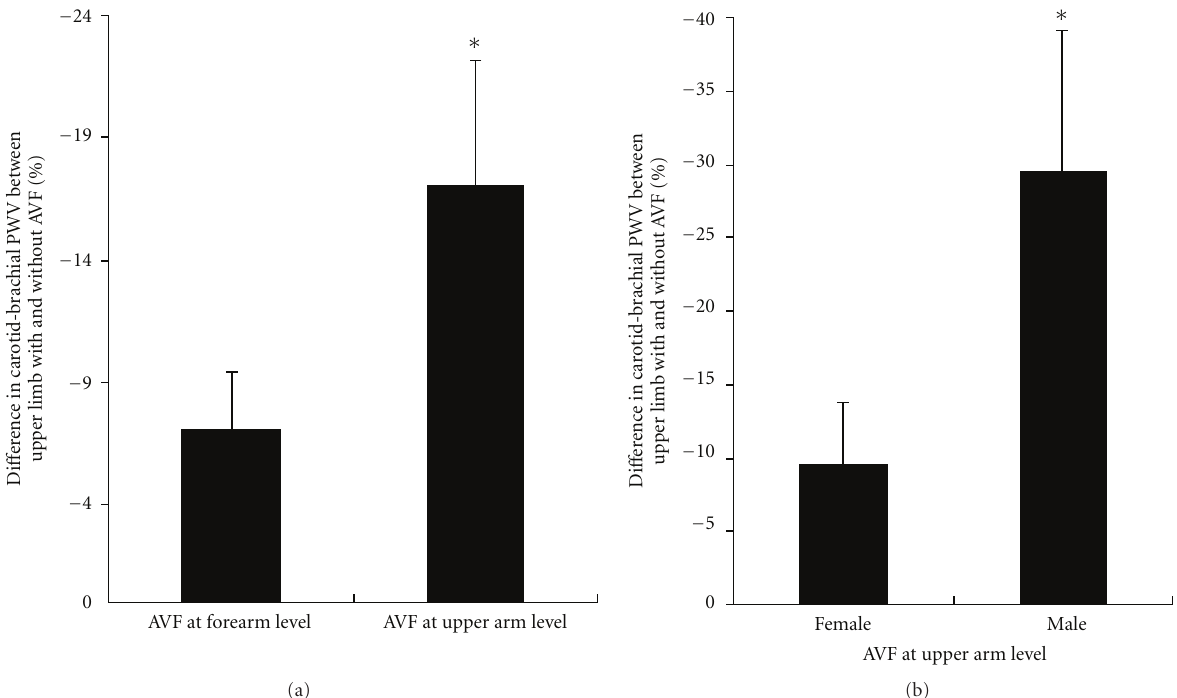
Figure 2: Carotid brachial pulse wave velocity (PWV) di ff erences (mean ± SD) between upper limbs with arteriovenous fistulas (AVF) with respect to their contralateral intact limbs. Di ff erences obtained at forearm level were lower than those obtained at upper arm level (a). At upper arm level, di ff erences obtained in females were lower than those obtained in males (b) ∗ P < 0 .